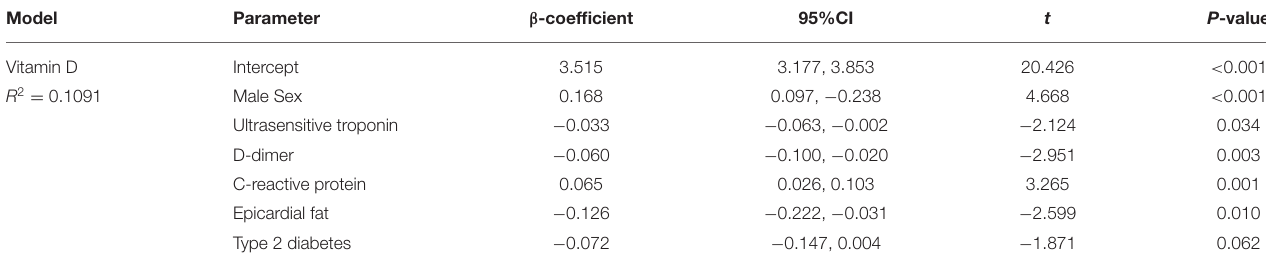
TABLE 2 | Multiple linear regression model to identify determinants of Vitamin D levels in patients with COVID-19. Model